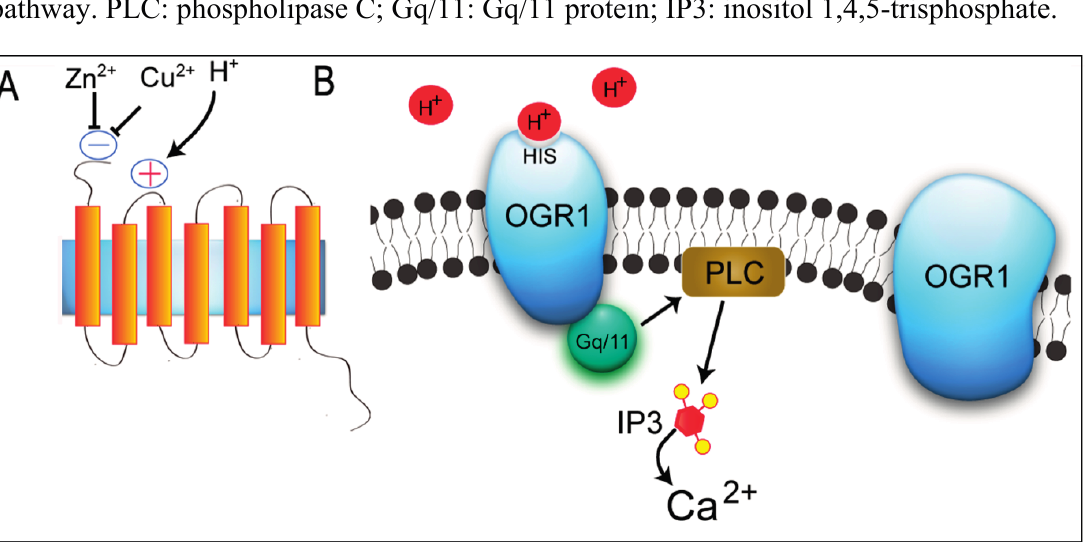
Figure 1. Activation of ovarian cancer G protein-coupled receptor 1 (OGR1) by extracellular acidification. ( A ) Proton has been suggested as an agonists of OGR1. Cu 2+ and Zn 2+ inhibit pH-dependent OGR1 activation; and ( B ) His residues that have been reported to be involved in proton-sensing process are bolded and underlined in OGR1. The interaction between protons and His residues of OGR1 leads to the activation of Gq/11/PLC/Ca 2+ pathway. PLC: phospholipase C; Gq/11: Gq/11 protein; IP3: inositol